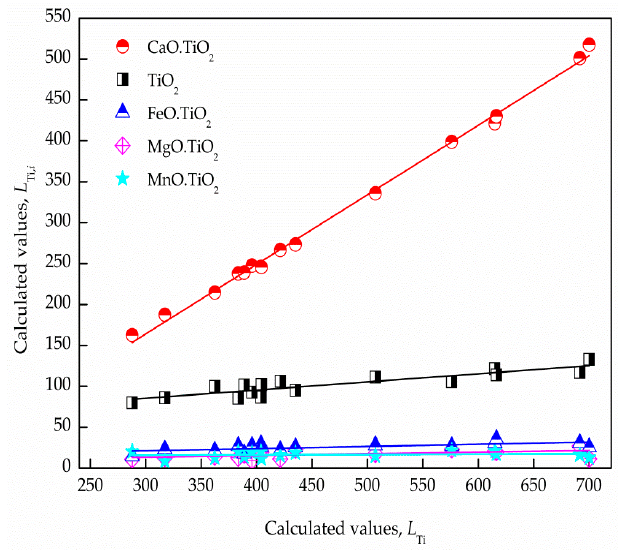
Figure 6. Correlation between the respective titanium distribution ratio and the total titanium distribution ratio of the slags, the solid line of color red, black, blue, magenta, and cyan represent the contribution ratio of CaO · TiO 2 , TiO 2 , FeO · TiO 2 , MgO · TiO 2 , and MnO · TiO 2 , respectively.